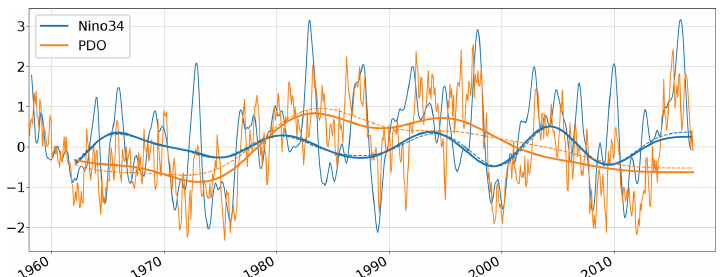
Figure A1. Niño3.4 index and PDO index, both calculated from REF025. Smoothed lines are bandpass-filtered with cutoff periods of 8 and 13 years (Niño3.4) and low-pass-filtered with cutoff periods of 13 years (PDO). Dashed lines show observational estimates of the PDO index (http://research.jisao.washington.edu/pdo/PDO.latest, last access: 8 June 2017; Mantua et al., 1997) and the Niño3.4 index (https: //psl.noaa.gov/gcos_wgsp/Timeseries/Data/nino34.long.data, last access: 7 June 2017; Rayner et al., 2003).